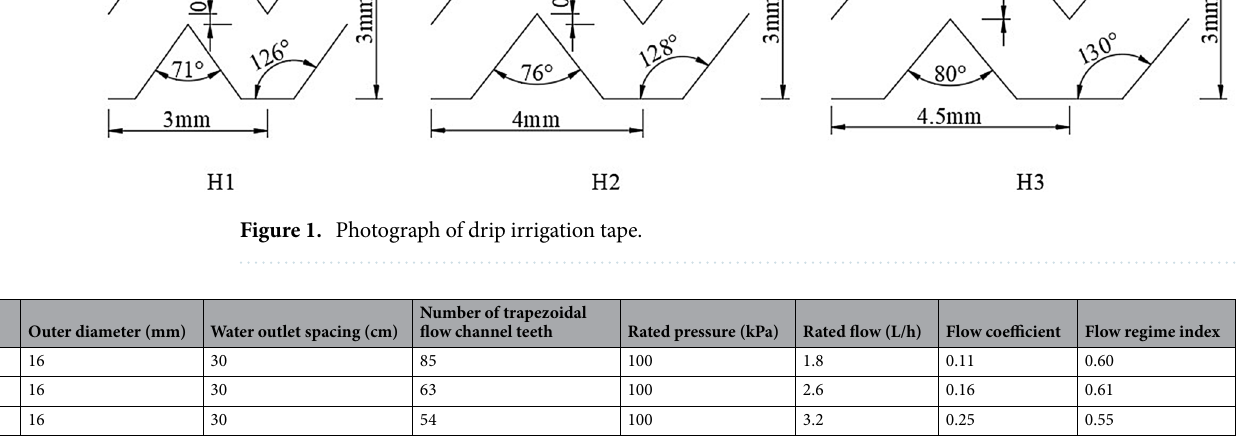
Table 1. Hydraulic performance parameters of studied drip irrigation